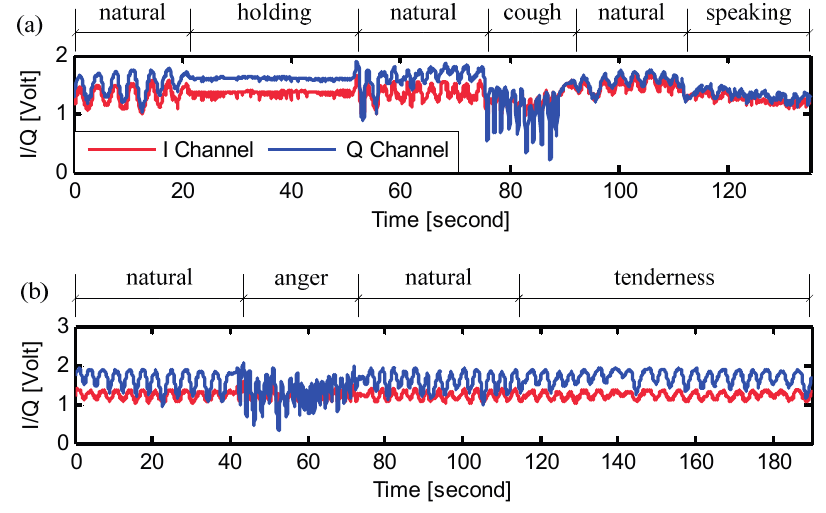
Figure 4. Signals measured at the abdomen of the subject showing the experimental procedures of ( a ) the assessment of physical breathing patterns; and ( b ) the assessment of emotional breathing